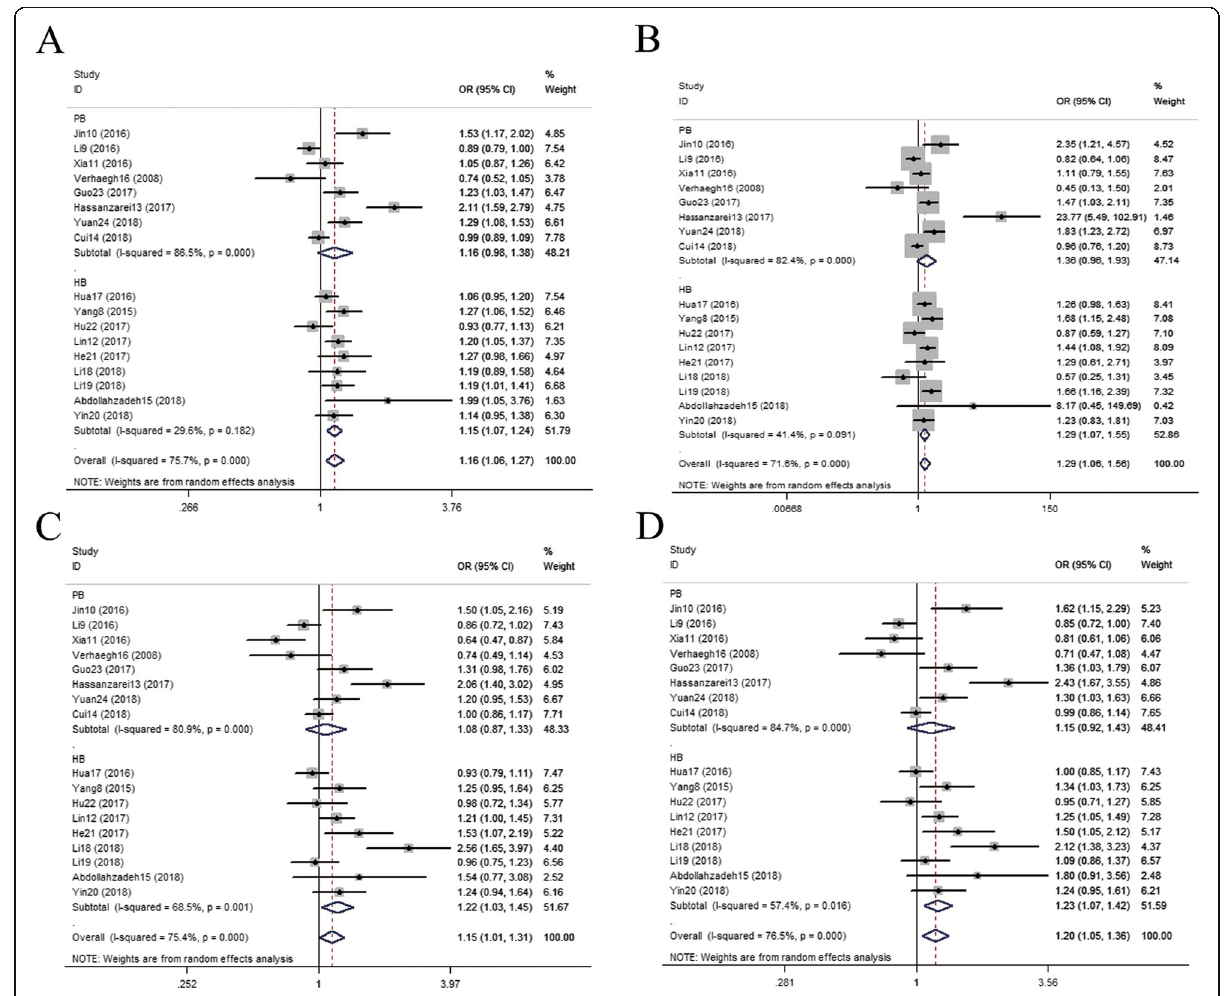
Fig. 3 Forest plots for H19 rs217727 polymorphism associated with risk of cancer in subgroup analysis under hospital-based controls. a Allelic model (T vs. C), b homozygote model (TT vs. CC). c Heterozygote model (CT vs. CC). d Dominant model [(CT + TT) vs.